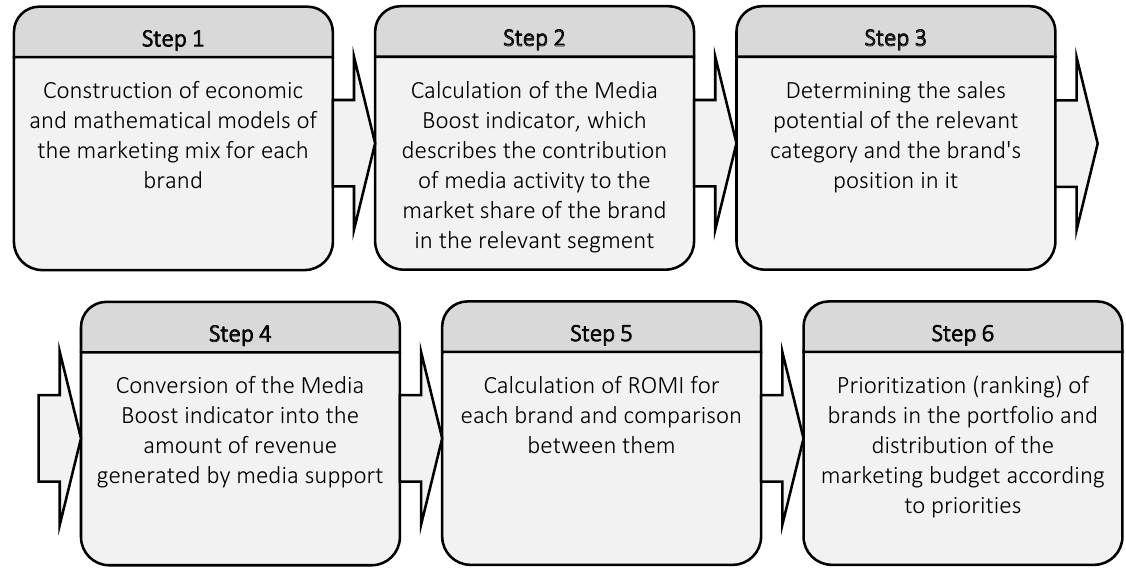
Figure 3. Approach to the formation of an effective portfolio marketing